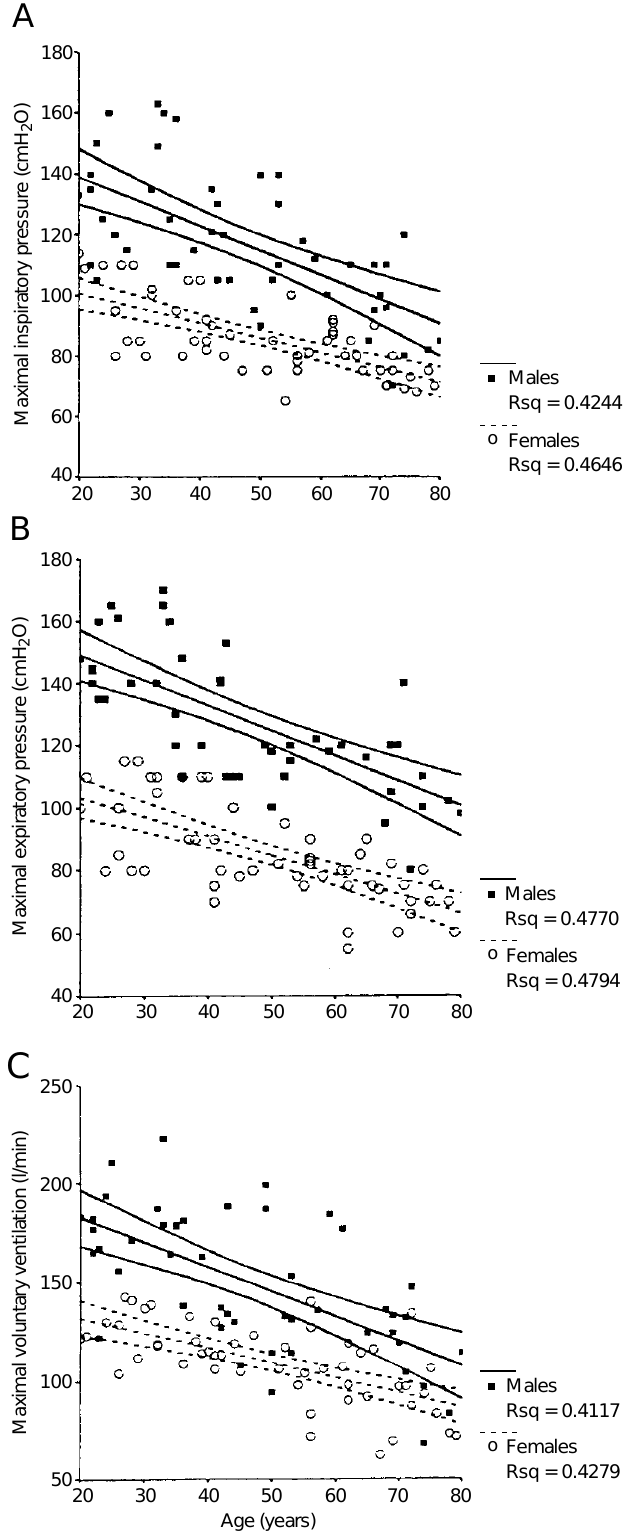
Figure 1 - Maximal inspiratory pressure (MIP) (A), expi- ratory pressure (MEP) (B) and voluntary ventilation (MVV) (C) as a function of age in 100 healthy sedentary subjects. Regression lines are presented with the cor- responding 95% confidence limits